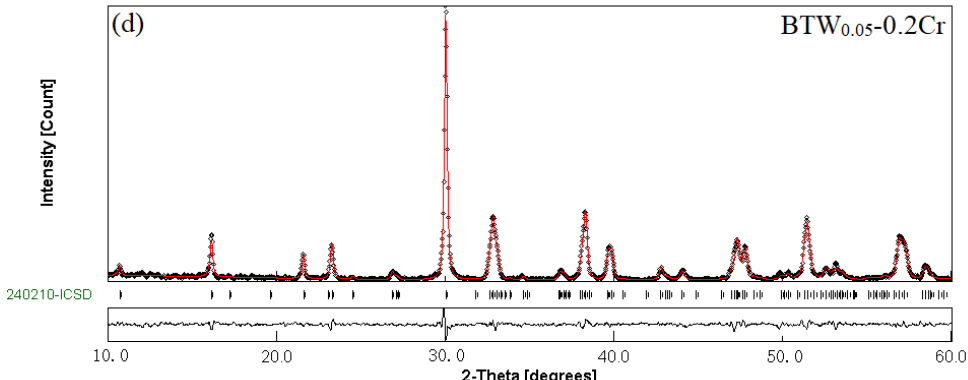
Figure 3. The observed (black circles), calculated (red curves), Bragg peaks position (vertical curves) and difference plots (obs-cal, black baselines) for the fit to the XRPD patterns of some BTWC ceramics after Rietveld refinement of the atomic structure at 295 K. ( a ) BIT; ( b ) BTW 0- 0.2Cr; ( c ) BTW 0.05- 0Cr; ( d ) BTW 0.05- 0.2Cr.